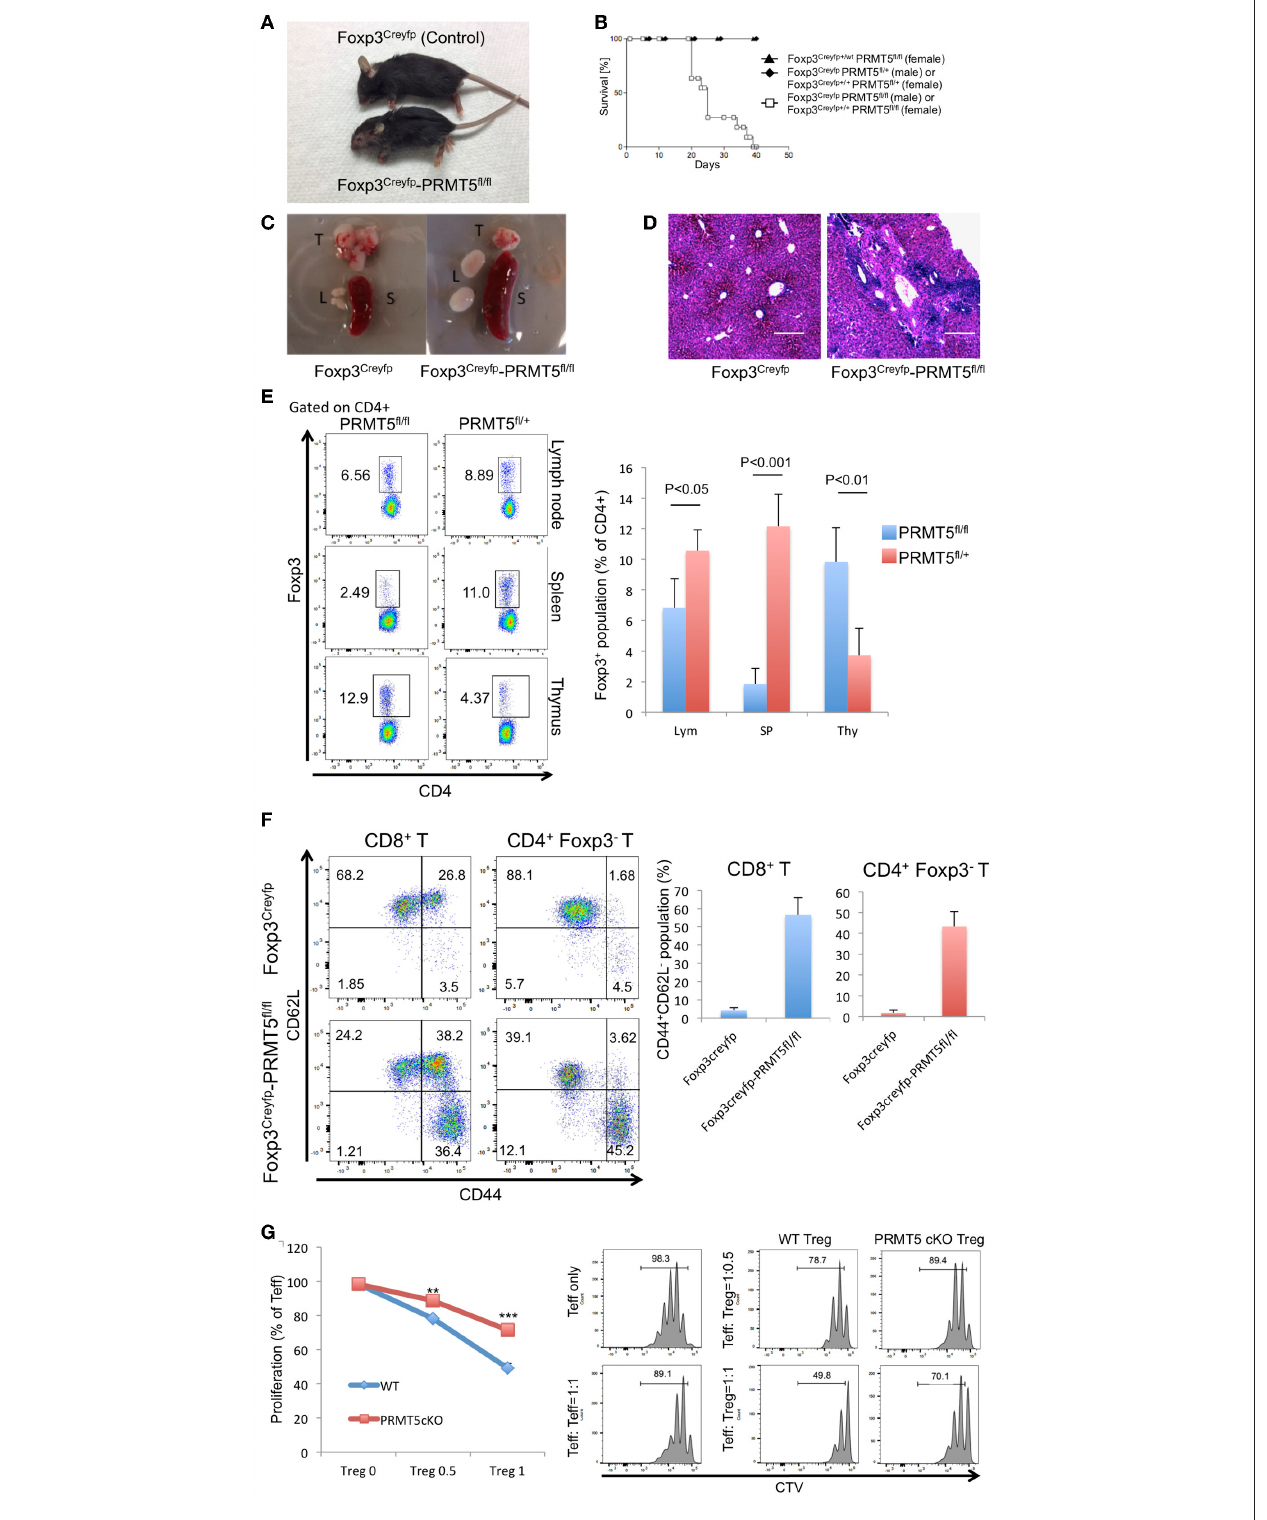
FIGURE 2 | Foxp3 Creyfp -PRMT5 fl / fl mice display scurfy-like symptoms. (A) phenotype of Foxp3 Creyfp -PRMT5 fl / fl mouse (male, 18–21 days old). (B) survival curve of Foxp3 Creyfp -PRMT5 fl / fl mouse (10 mice). (C) spleen (S), thymus (T), and lymph nodes (L) from Foxp3 Creyfp and Foxp3 Creyfp -PRMT5 fl / fl mouse. (D) H&E staining